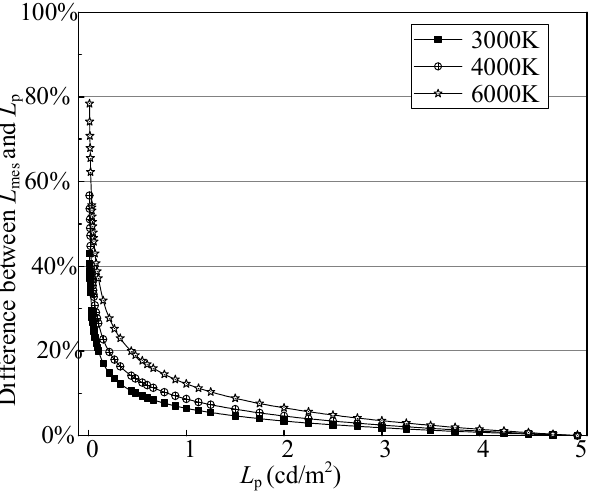
Figure 5. Percentage difference between L mes and L p plotted against L p .